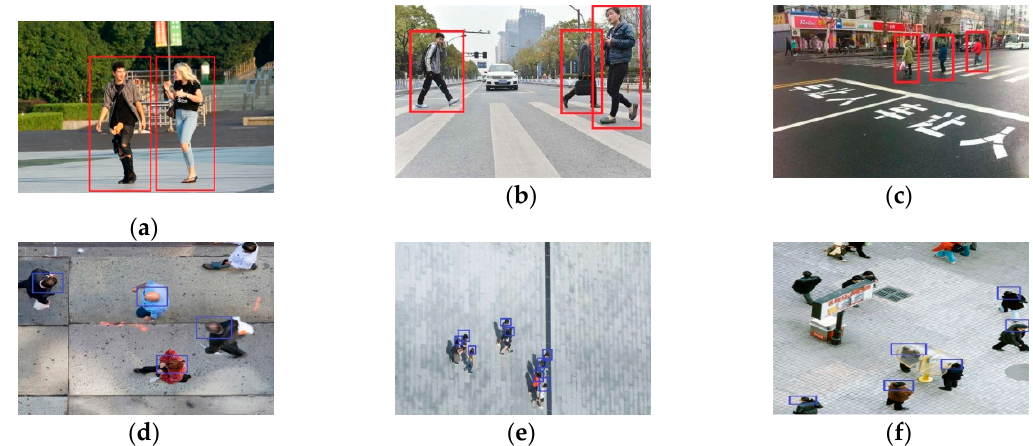
Figure 2. ( a – c ) are methods based on the whole body. ( d – f ) are methods based on a part of the